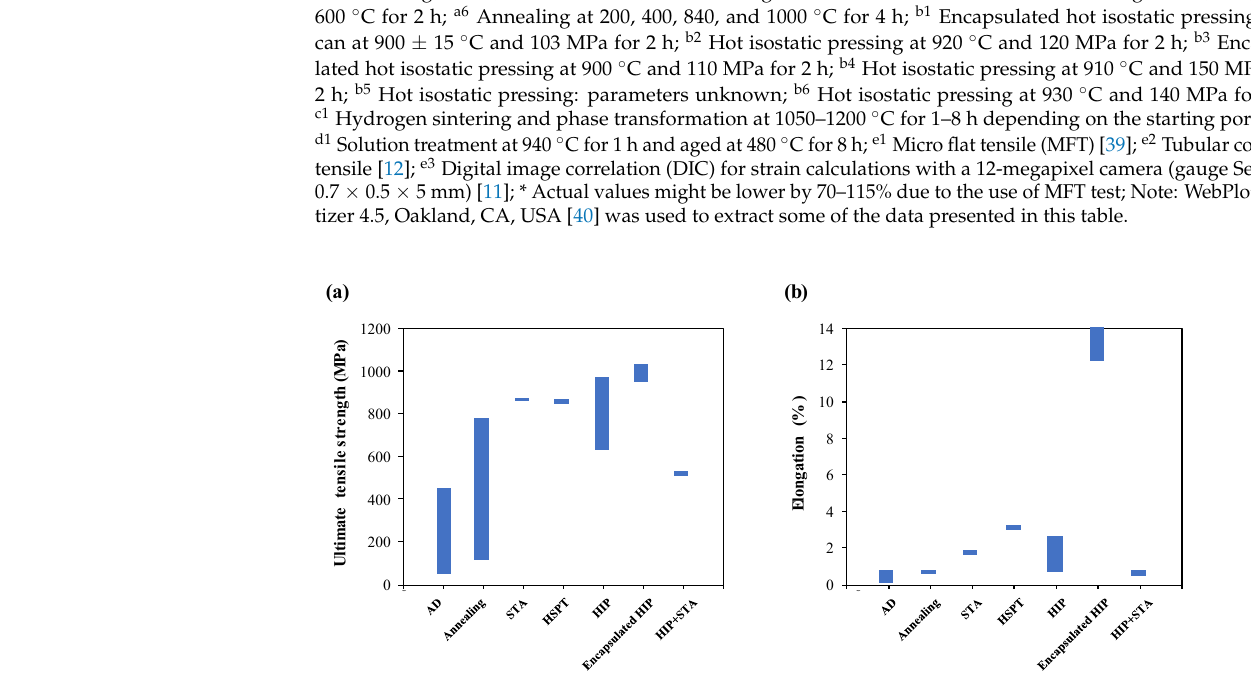
Figure 6. Effect of various post-deposition thermal treatments on improving tensile properties of fully CS deposited Ti6Al4V alloy (data collated from literature [3,8–11,13–16] and this study): ( a ) ultimate tensile strength (UTS), ( b ) elongation. ( a , b ) presents the range of UTS and elongation values for various testing conditions: as-deposited (AD), annealing, solution treatment and ageing (STA), hydrogen sintering and phase transformation (HSPT), hot isostatic pressing (HIP), encapsulated HIP, and HIP + STA.